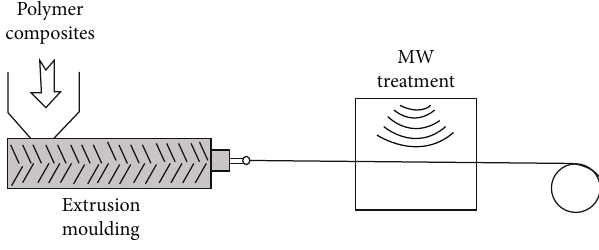
Figure 20: Schematic representation of the process of polypropylene foaming within a MW cavity coupled to